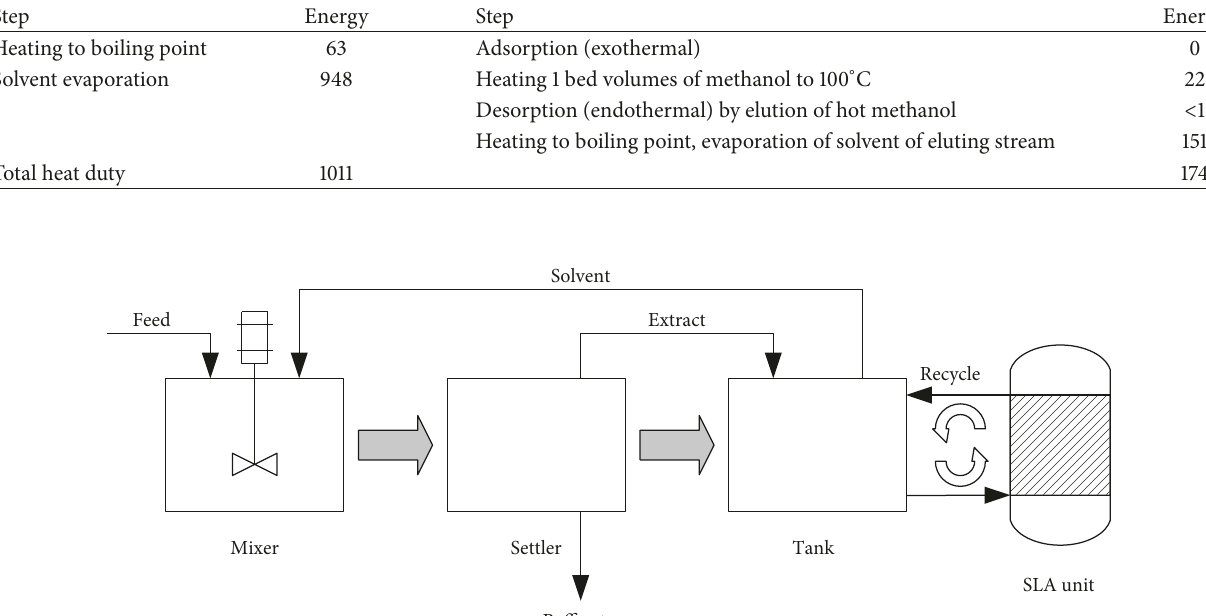
Figure 13: Flowsheet of a sequential discontinuous combination of extraction tank and adsorption column with fast recycle. Dimensions and process parameters: 𝑊 Ads = 1334 kg, 𝑉 Feed = 0.24 m 3 , 𝑉 Solv = 4.8 m 3 , 𝑥 Feed = 140mmol L −1 , 𝑇 = 303